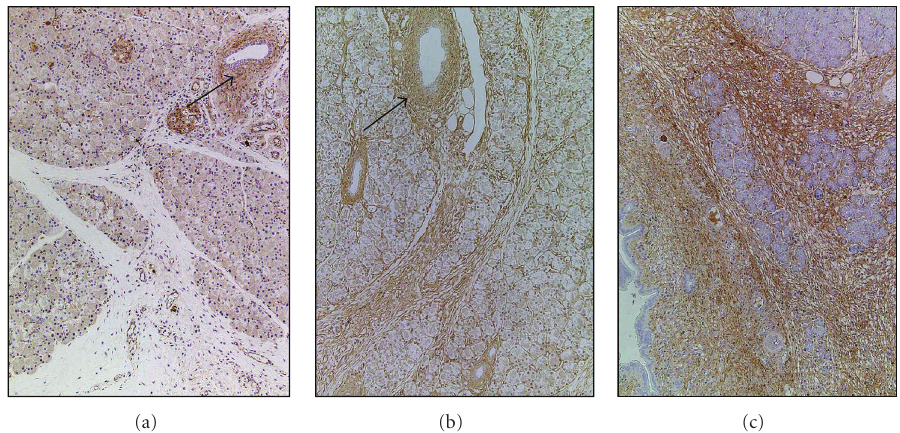
Figure 7: Immunohistochemistry for collagen type I (a), collagen type III (b), and fibronectin (c) in the pancreas on day 14 after the induction of PDH. (a) Collagen type I was markedly distributed around the pancreatic duct but was slightly distributed in interlobular and intralobular areas. (b, c) Collagen type III (b) and fibronectin (c) were markedly distributed in interlobular and intralobular areas and around the pancreatic duct × 100.